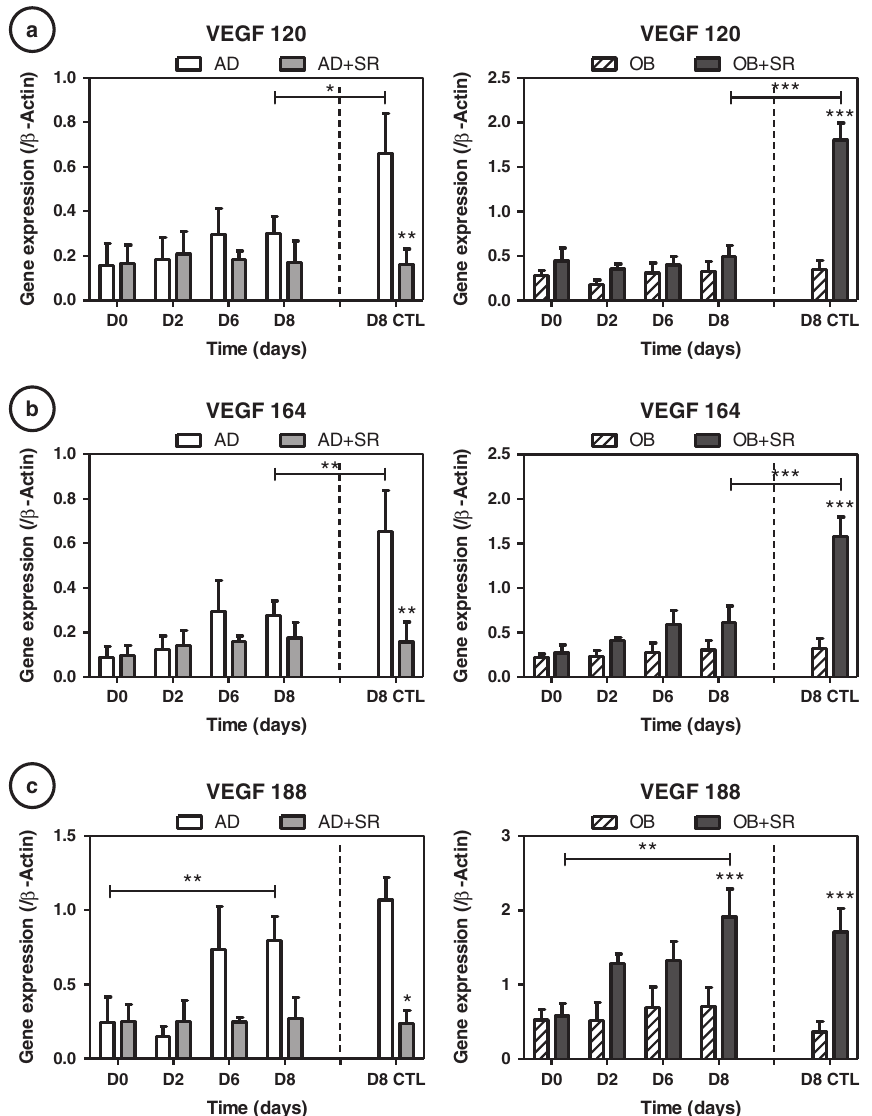
Fig. 6 Strontium (SR) differentially regulates VEGF188 isoform expression in osteogenic (OB) and adipogenic(AD) conditions: VEGF isoforms ( a : 120, b : 164 and c : 188) were measured at days 2, 6 and 8 by RT-quantitative PCR during the cultures in AD or OB media, with or without 5 mM strontium. Day 8 of control static condition corresponds to the D8 CTL data. Error bars represent S.E.M. * p < 0.05 and ** p < 0.01 compared to media without strontium ( N = 3 independent